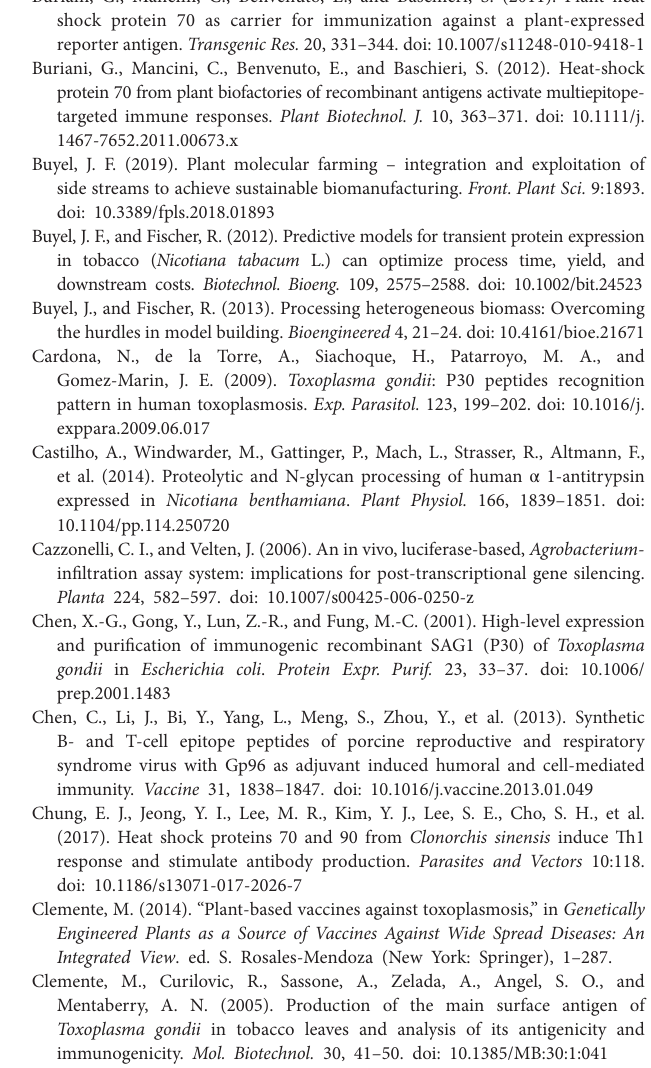
Supplementary Figure S1 | The nucleotide and amino acid sequence of the native SAG1 from T. gondii . (A) The signal peptide and the C-terminal hydrophobic region to generate the mature SAG1 77-322 version are indicated in grey letters. (B) Arrows indicate the cleavage sites to generate the mature SAG1 version (SAG1 m ). The underlined sequence corresponds to the truncated version of the SAG1 protein called SAG1 HC . The bold letters and bold and italics letters indicate the B- and T-cell response epitopes sequences, respectively. Supplementary Figure S2 | SAG1 HC -specific immunoglobulin (Ig)Gt, IgG1, and IgG2b antibody titers of serum samples. At 35 and 42 days after immunization, blood samples from the eight mice in each group were obtained. Serum samples from each group of mice were pooled, and serial dilutions were analyzed by direct ELISA. plAtHsp81.2-SAG1 HC : mice vaccinated with AtHsp81.2-SAG1 HC -infiltrated leaf extracts, rAtHsp81.2-SAG1 HC : mice vaccinated with rAtHsp81.2–SAG1 HC purified from AtHsp81.2-SAG1 HC -infiltrated leaves, control: mice vaccinated with non-infiltrated leaf extracts, and PBS: mice vaccinated with phosphate-buffered saline 1X. Results are expressed as endpoint titers, defined as the highest dilution that gave a value above the cutoff. Cutoff values are those of the control and PBS